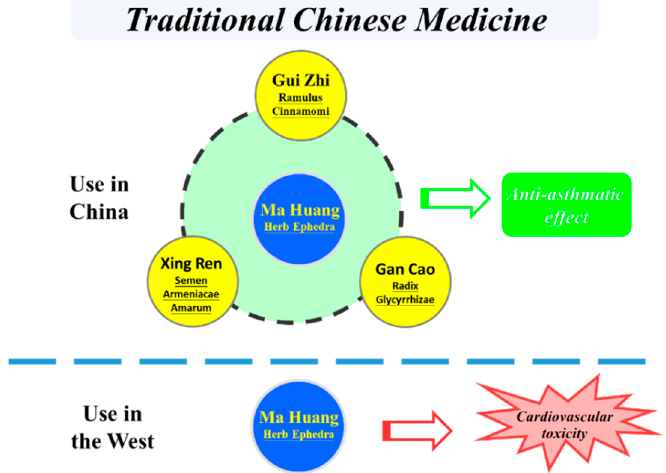
Figure 3. In TCM, herbs are combined together in a specific proportion to treat disease efficiently with low side effects. This is exemplified with the herb formula that contains Ma Huang as the most effect herb to treat asthma. In the West, Ma Huang is used alone and in relatively high doses, which is prone to cardiovascular side effects.